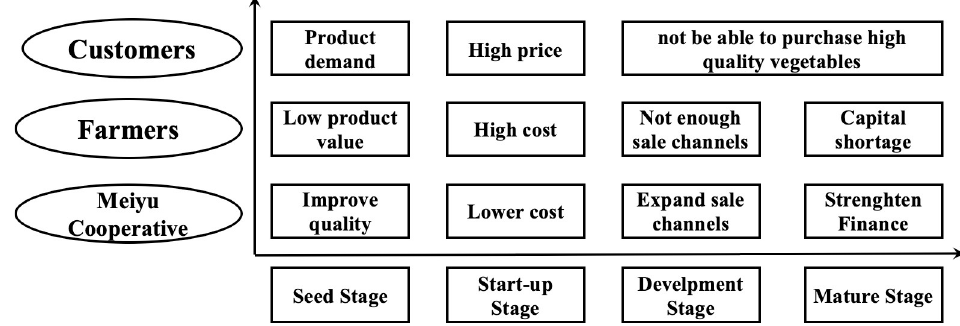
Fig 2. The Meiyu Cooperative’s, farmers’, and customers’ problematization in different stages.